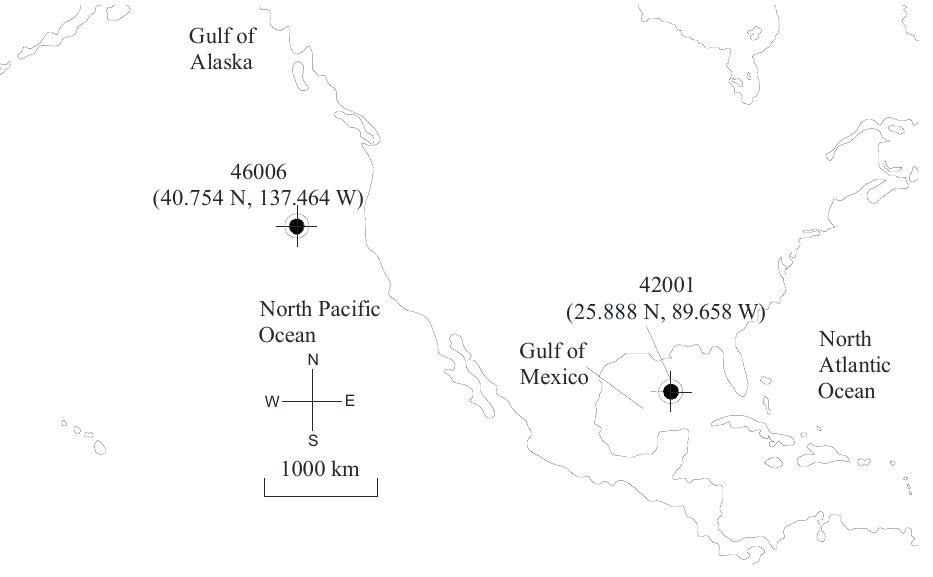
Figure 3. Locations of the buoys 46006 and